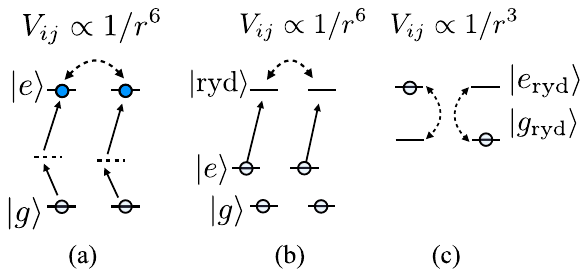
Fig. 14 Qubit encodings for Rydberg atoms. a Ground and Rydberg state as qubit states. Atoms are excited from the ground to the Rydberg state via a two-photon transition. Rydberg atoms interact with a van- der-Waals interaction. b Two ground states as qubit states. Interactions are induced by exciting | e (cid:7) to or dressing | e (cid:7) with a Rydberg state. c Two Rydberg states as qubit states. They undergo flip-flop interactions due to their dipole moments